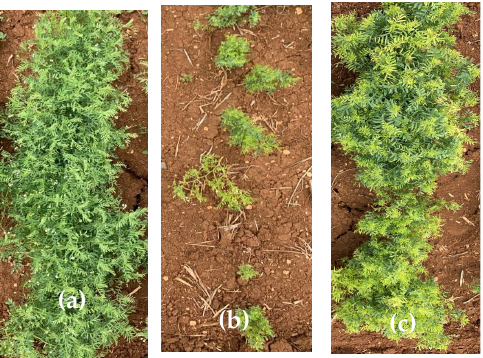
Figure 1. IG115370 ( a ) plot with no herbicide treatment; ( b ) plot treated with imazethapyr; ( c ) plot treated with metribuzin.